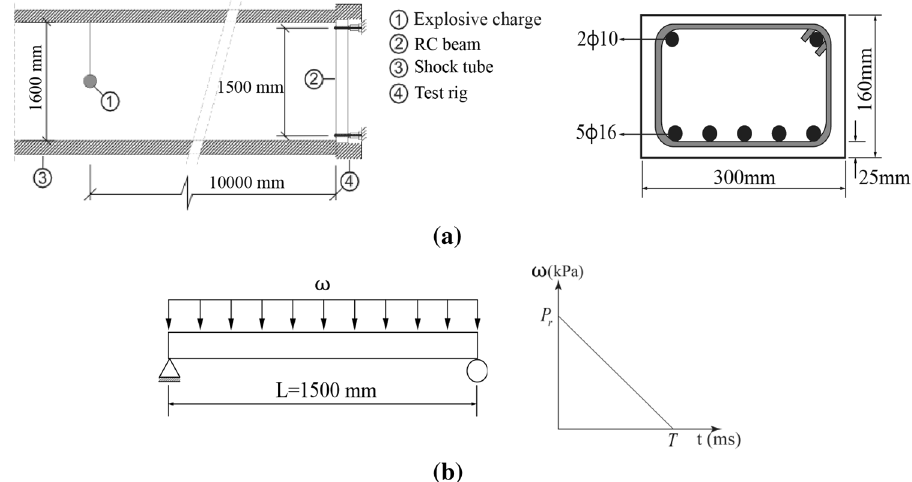
Fig. 6 Geometry and loading history for B40_D1 and B40_D2 (Magnusson and Hallgren 2000). a Experimental setup and section details and b configuration of B40_D1 and B40_D2 and blast loading.